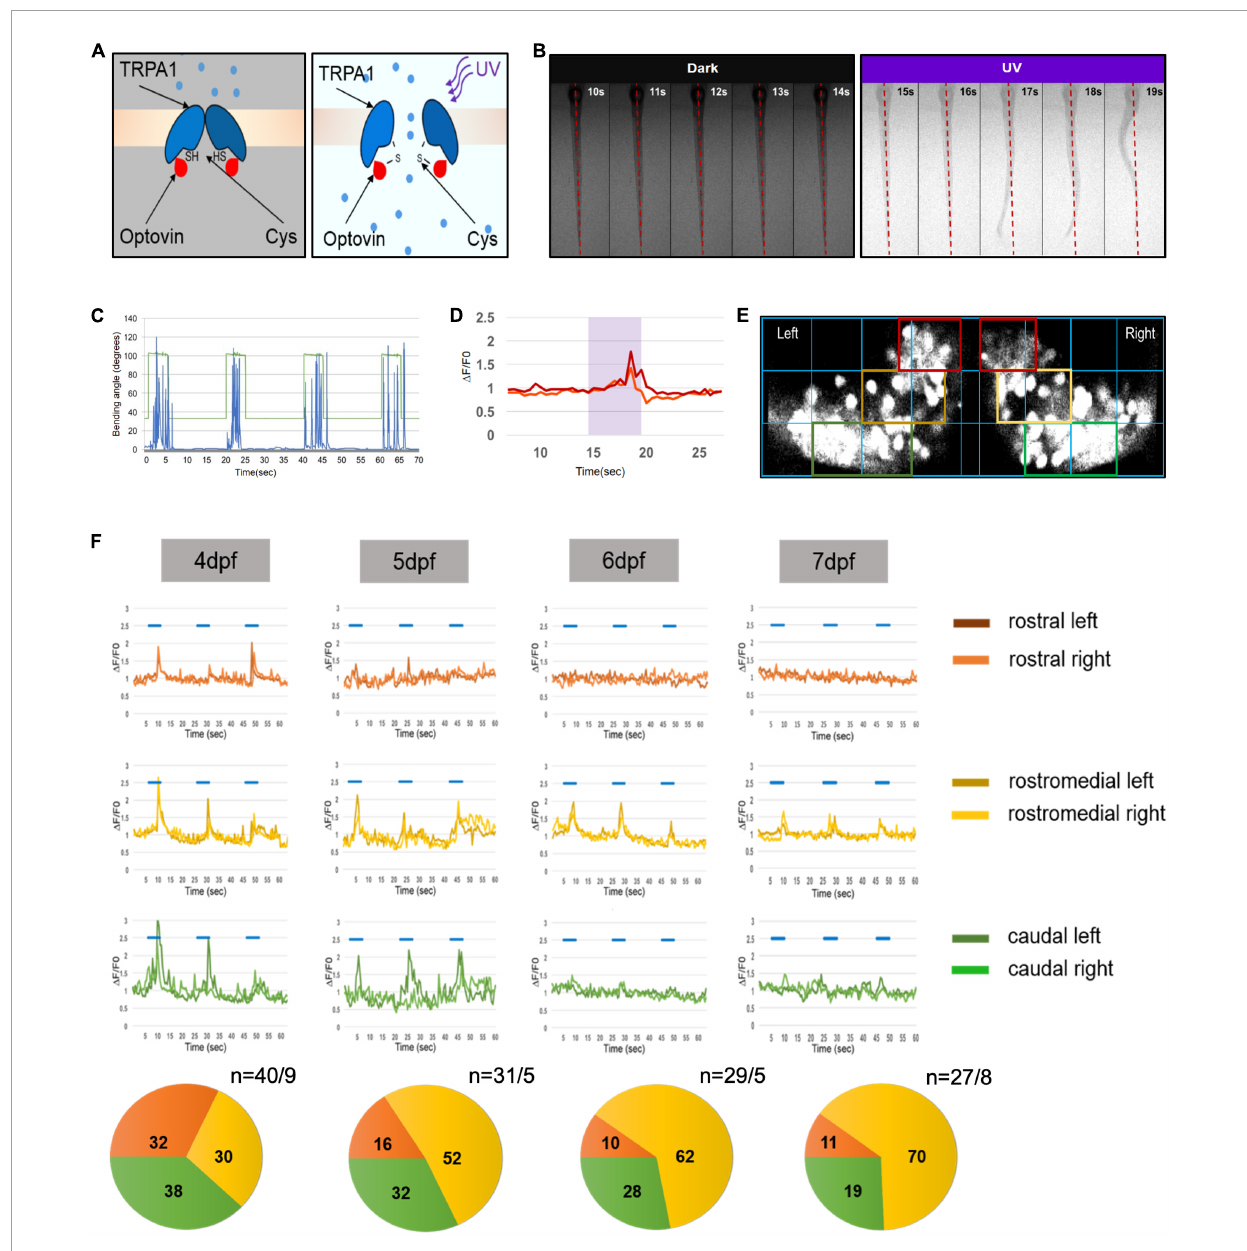
FIGURE1 Progressive development of functional domains in the zebrafish Purkinje cell (PC) population during cerebellar development. (A) Graphic illustration of transient receptor potential A1 (TrpA1) channel activation in sensory neurons of the trunk by UV illumination of Optovin. (B) Montage of consecutive frames of 1 s intervals showing deflection of trunk in the presence of Optovin with and without UV light (red dashed line marks dorsal midline during resting state). (C) Graph illustrating angle of bending of trunk (blue peaks) during the time UV light was on (peaks in green) and off (green line). (D) Examples of Ca 2 + transient amplitudes (red and orange) during Optovin induced swimming upon UV illumination (period marked in turquoise). (E) The grid used to define rostral (red boxes), rostromedial (yellow boxes) and caudal territories (green boxes) in the zebrafish PC layer expressing the calcium indicator GCaMP5G. (F) Illustration of measured swimming correlated Ca 2 + transients (?F/F0) of different regions of PC layer from 4 to 7 dpf (blue lines indicate periods of UV-illumination). Pie charts below display the percentage of swimming-correlated Ca 2 + -transients within the different PC regions with respect to days of analysis. To the right of pie charts n indicates number of recorded transients/number of larvae.